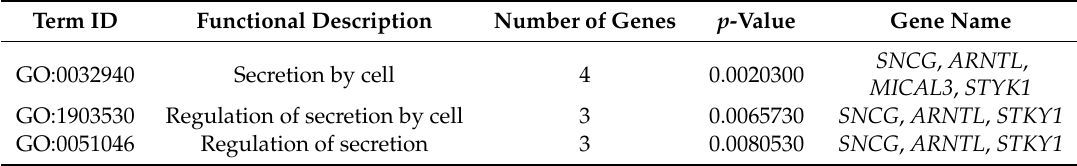
Table 5. The significantly enriched biological process terms for the four-week-old females.